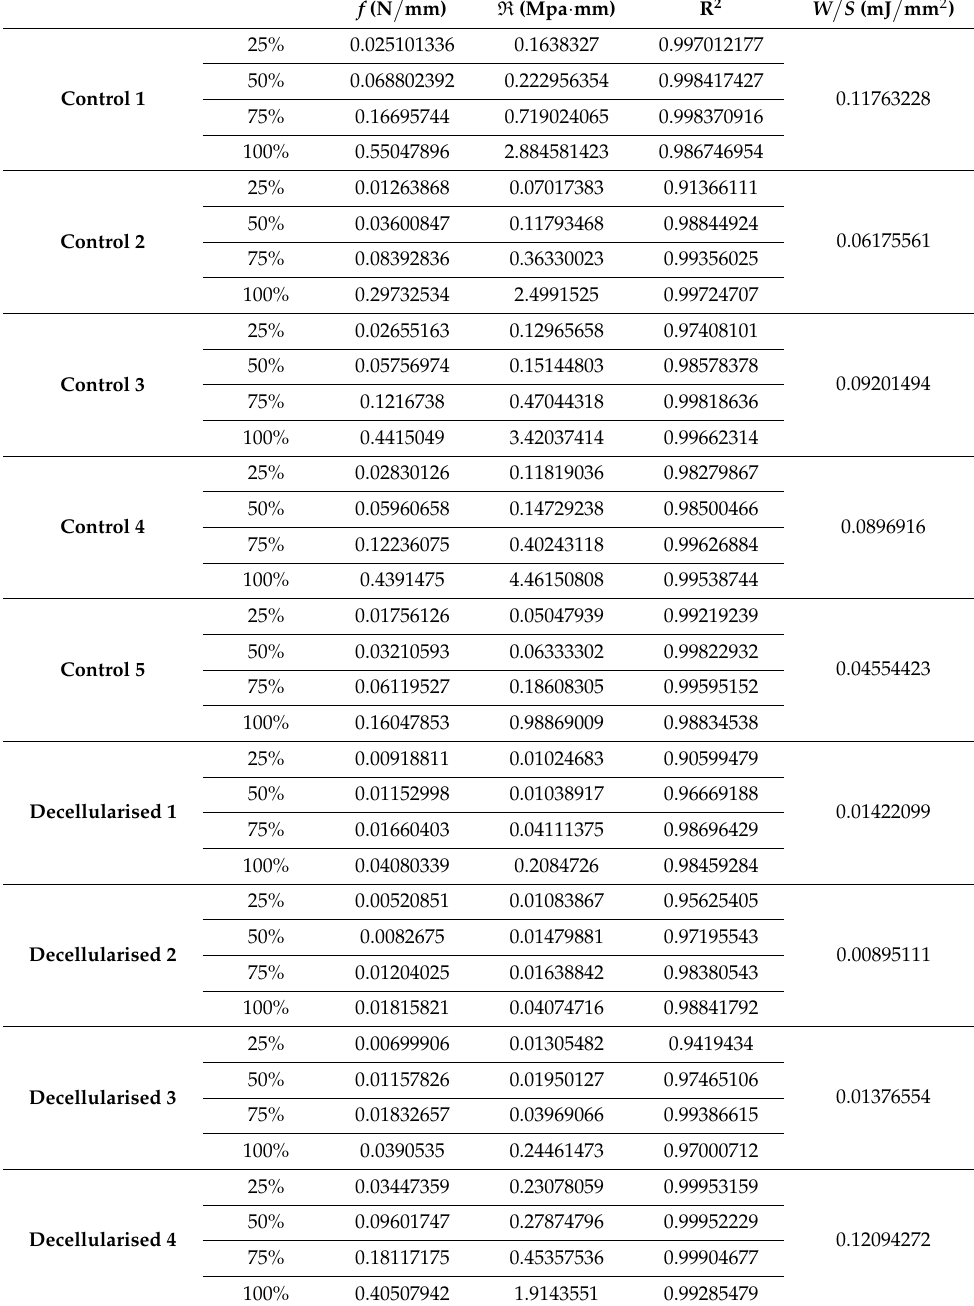
Table A2. Compression tests on control and decellularised